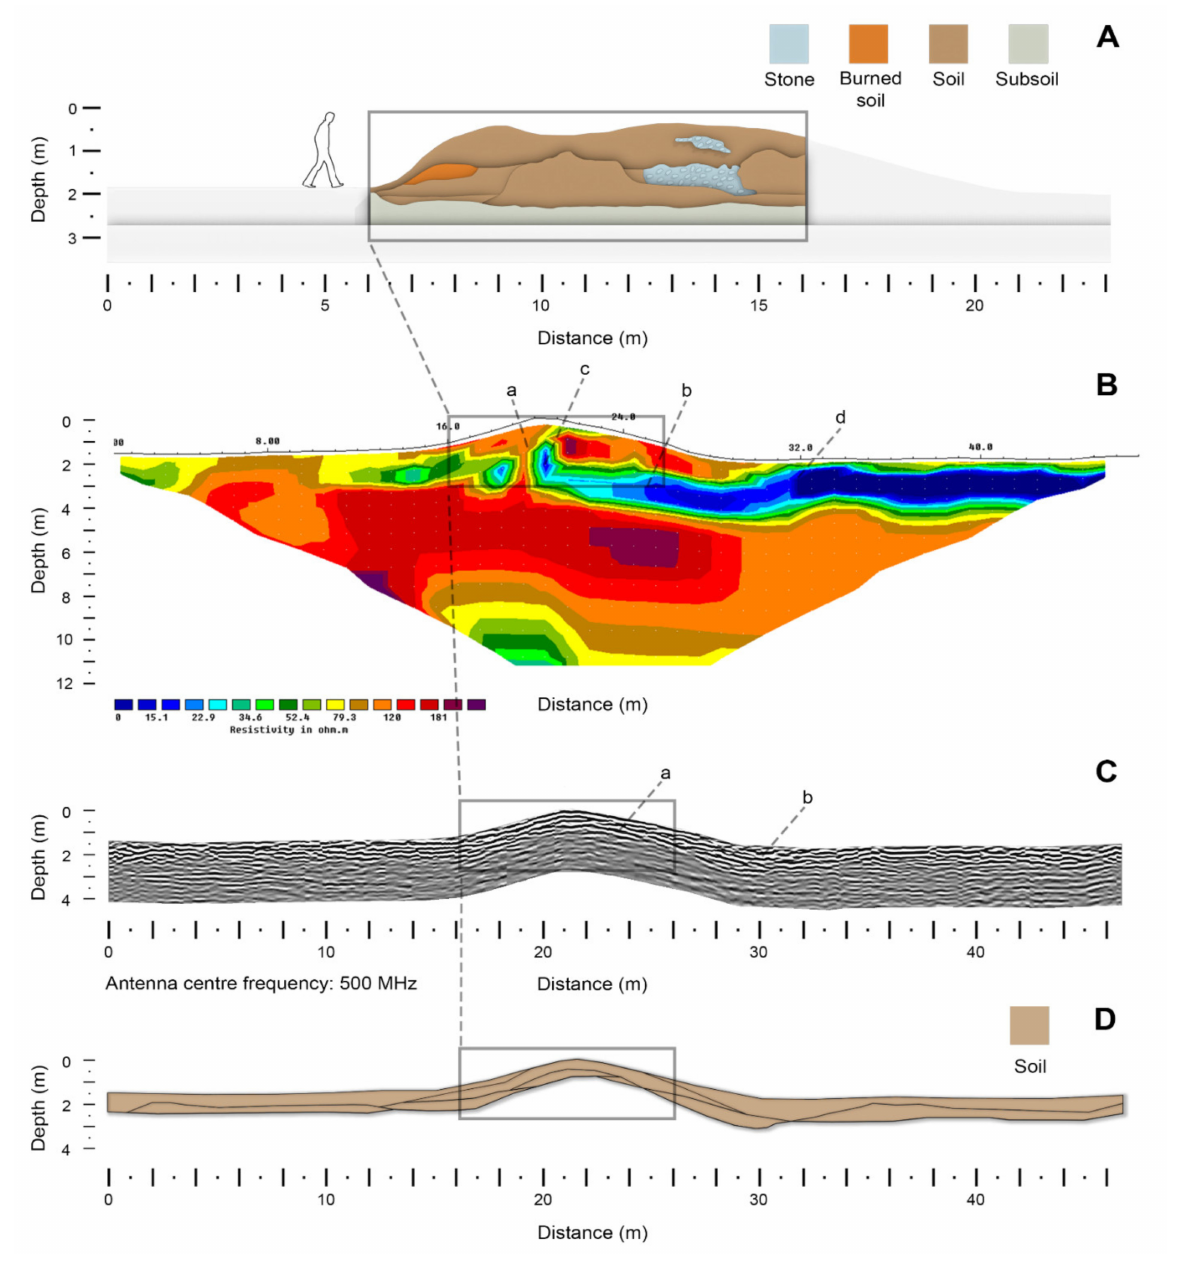
Figure 11. Nejdek. ( A ): Profile of the hillfort’s fortification based on the results of archaeological exca- vation ([9], Figure 114). ( B ): Electrical resistivity tomography model in double dipole configuration of the surveyed fortification of the hillfort’s acropolis. ( C ): GPR vertical time/depth radarogram from an antenna with 500 MHz centre frequency. ( D ): Interpretation of the GPR